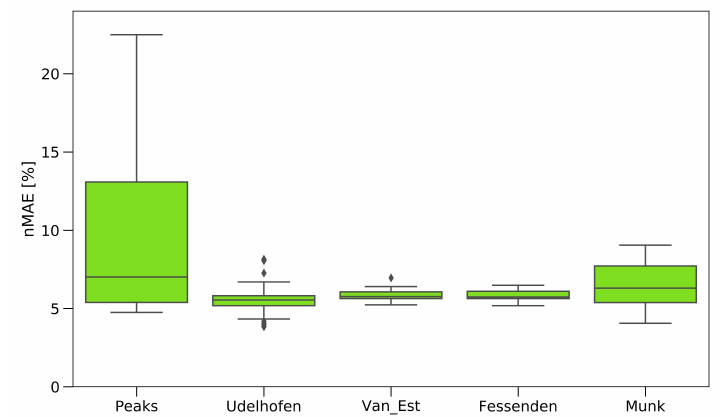
Figure 12. Influence of pre-processing algorithms on the accuracy of the prediction.